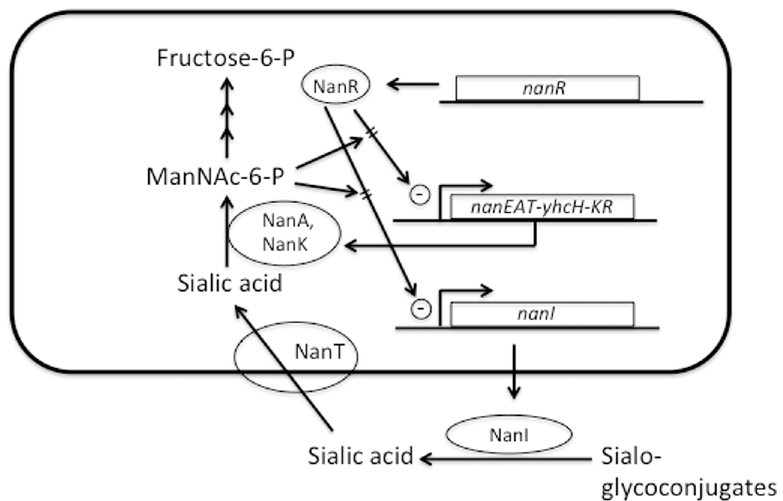
Fig 8. Model showing the operation of a positive feedback loop for nanI and nanEAT-yhcH-nanKR in vivo . See text for detailed description of the model